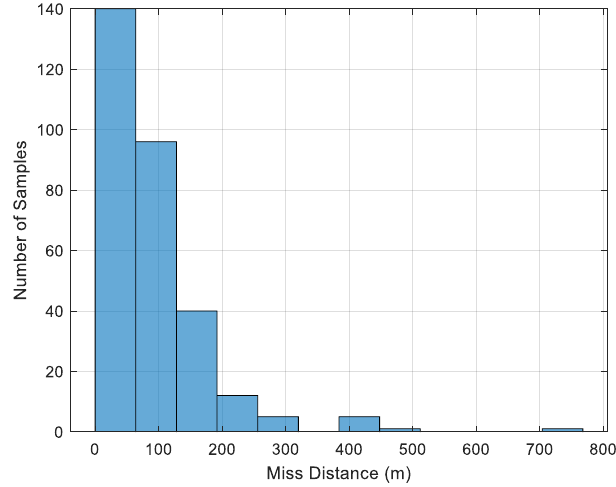
Figure 28. Guided Rocket